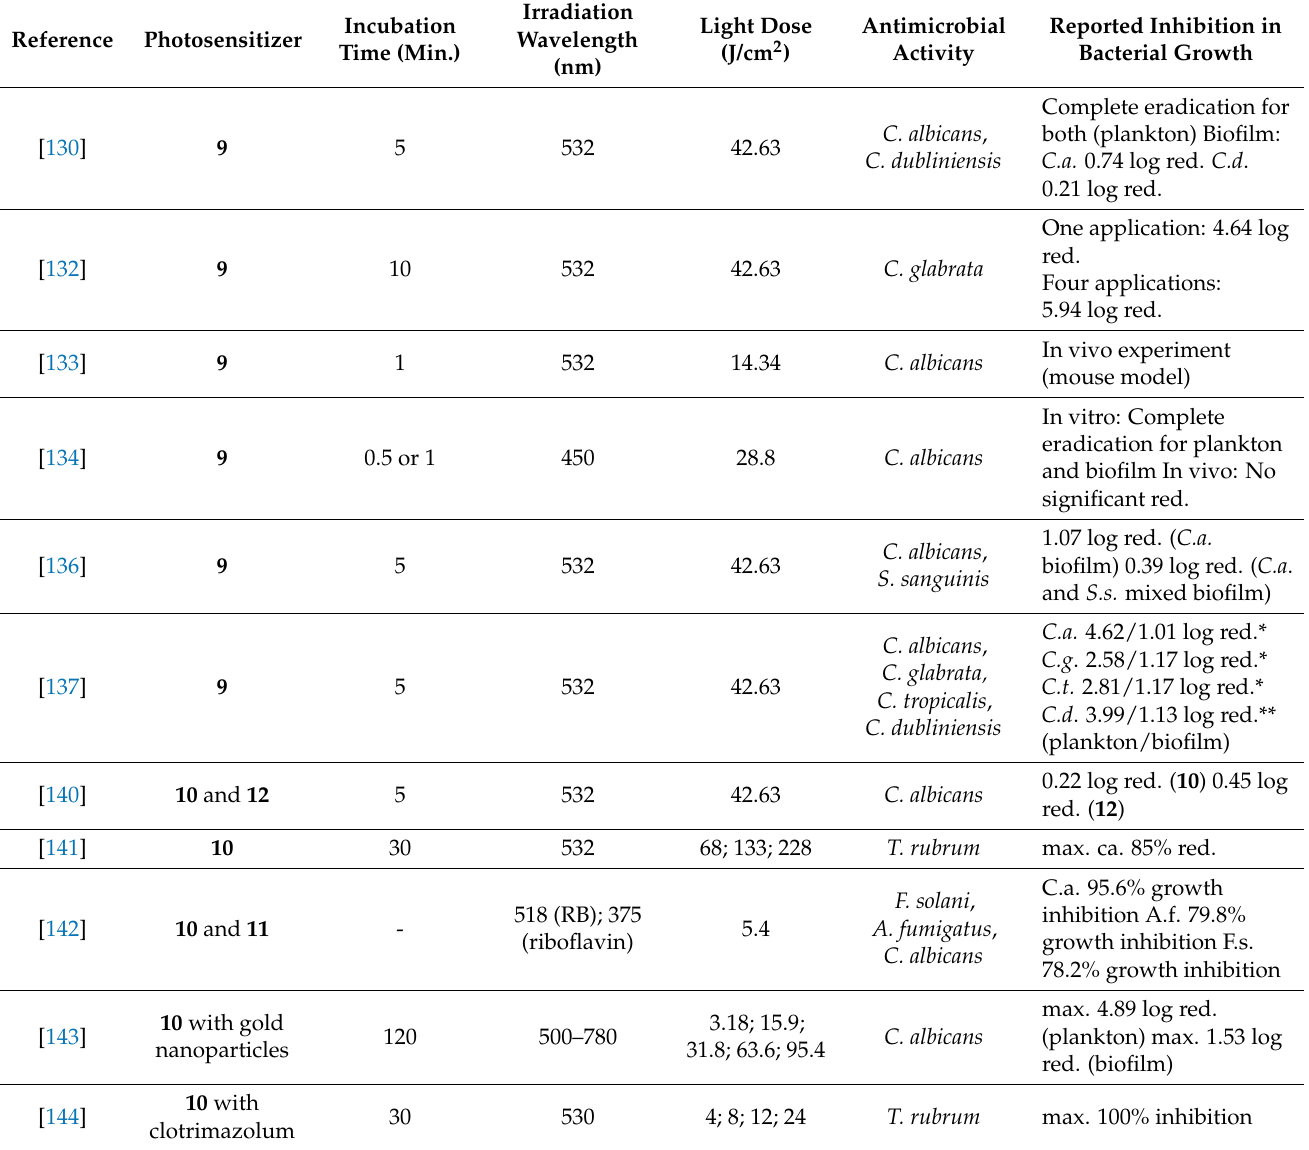
Table 2. Xanthenes—photodynamic antimicrobial activity and